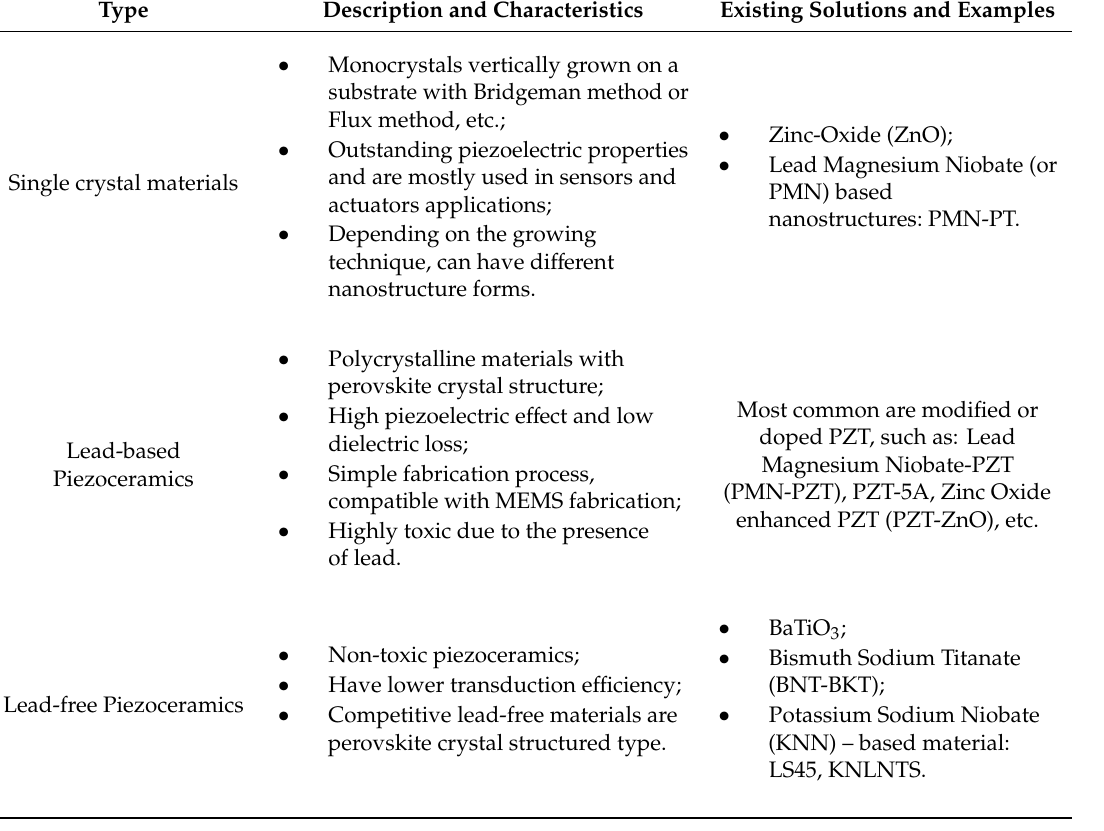
Table 1. Characteristics of piezoelectric material types